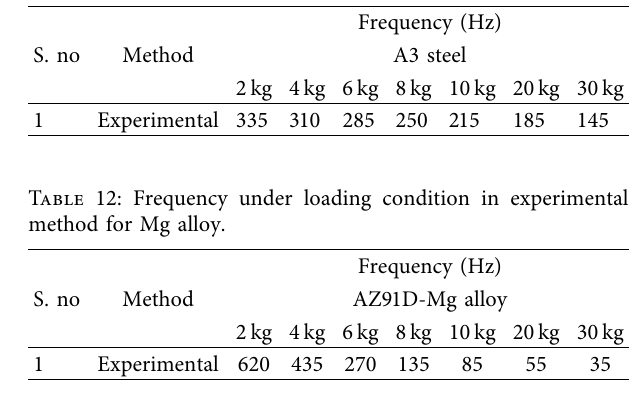
Table 11: Frequency under loading condition in experimental method for A3 steel.